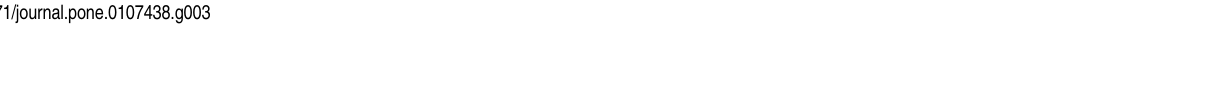
Figure 3. Scanning electron microscopy of oxo-biodegradable plastic before (Ox0duv) and after 30 (Ox30duv), 60 (Ox60duv), 90 (Ox90duv) and 120 days (Ox120duv) of sunlight